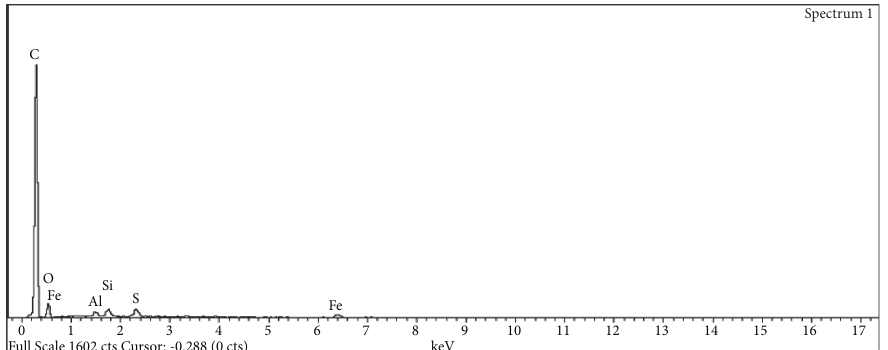
Figure 3: Elemental spectrum for CSAC.